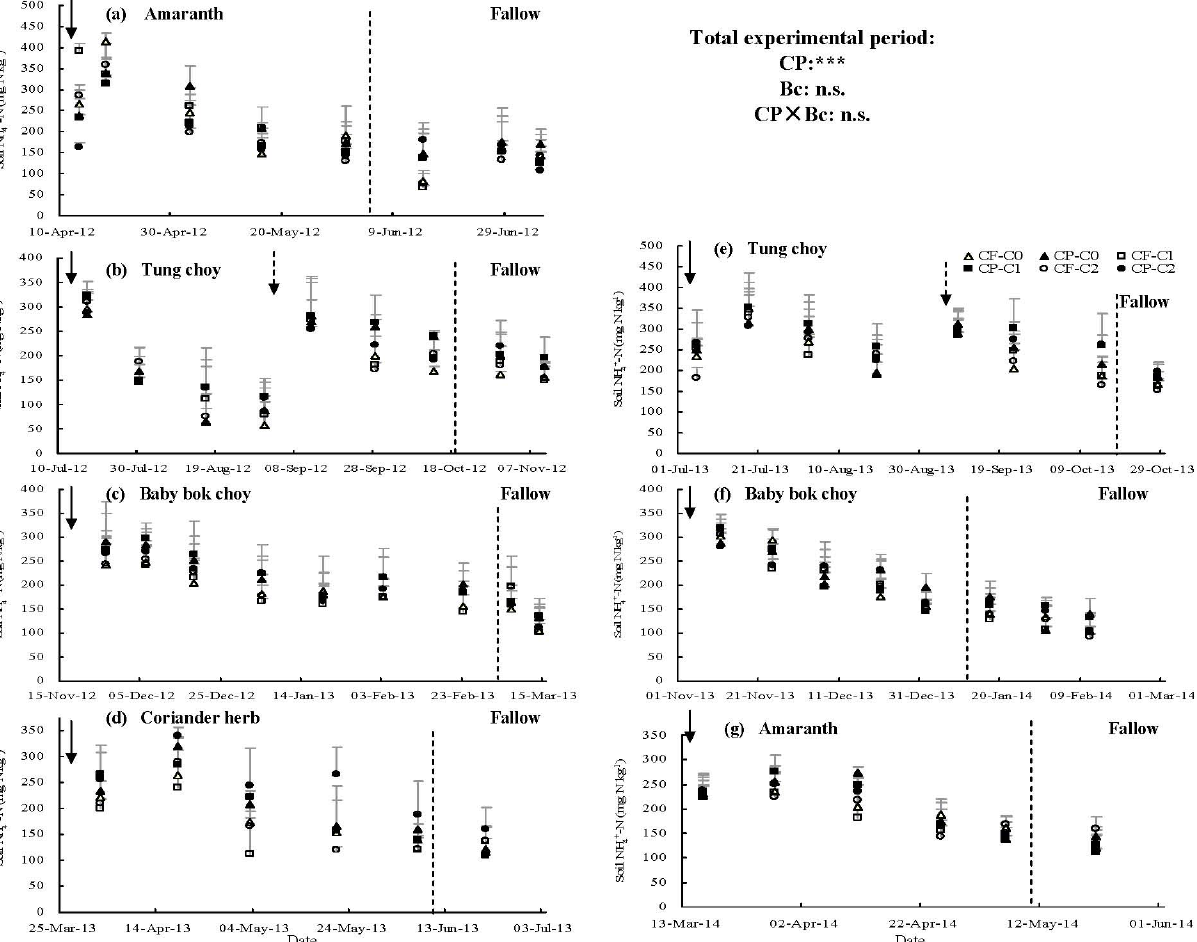
Figure 3. Dynamics of the soil NH + -N concentrations within the 0–15cm of soil under different treatments in vegetable fields with seven 4 consecutive vegetable crops from 2012 to 2014 in southeastern China. The solid and dashed arrows indicate basal fertilization and topdress- ing, respectively. The dashed vertical line in each subfigure separates different vegetable growth periods. The bars indicate the standard error of the mean ( + SE) for the three replicates of each treatment. See Table 2 for treatment codes. ∗∗∗ p < 0.001; n.s. – not